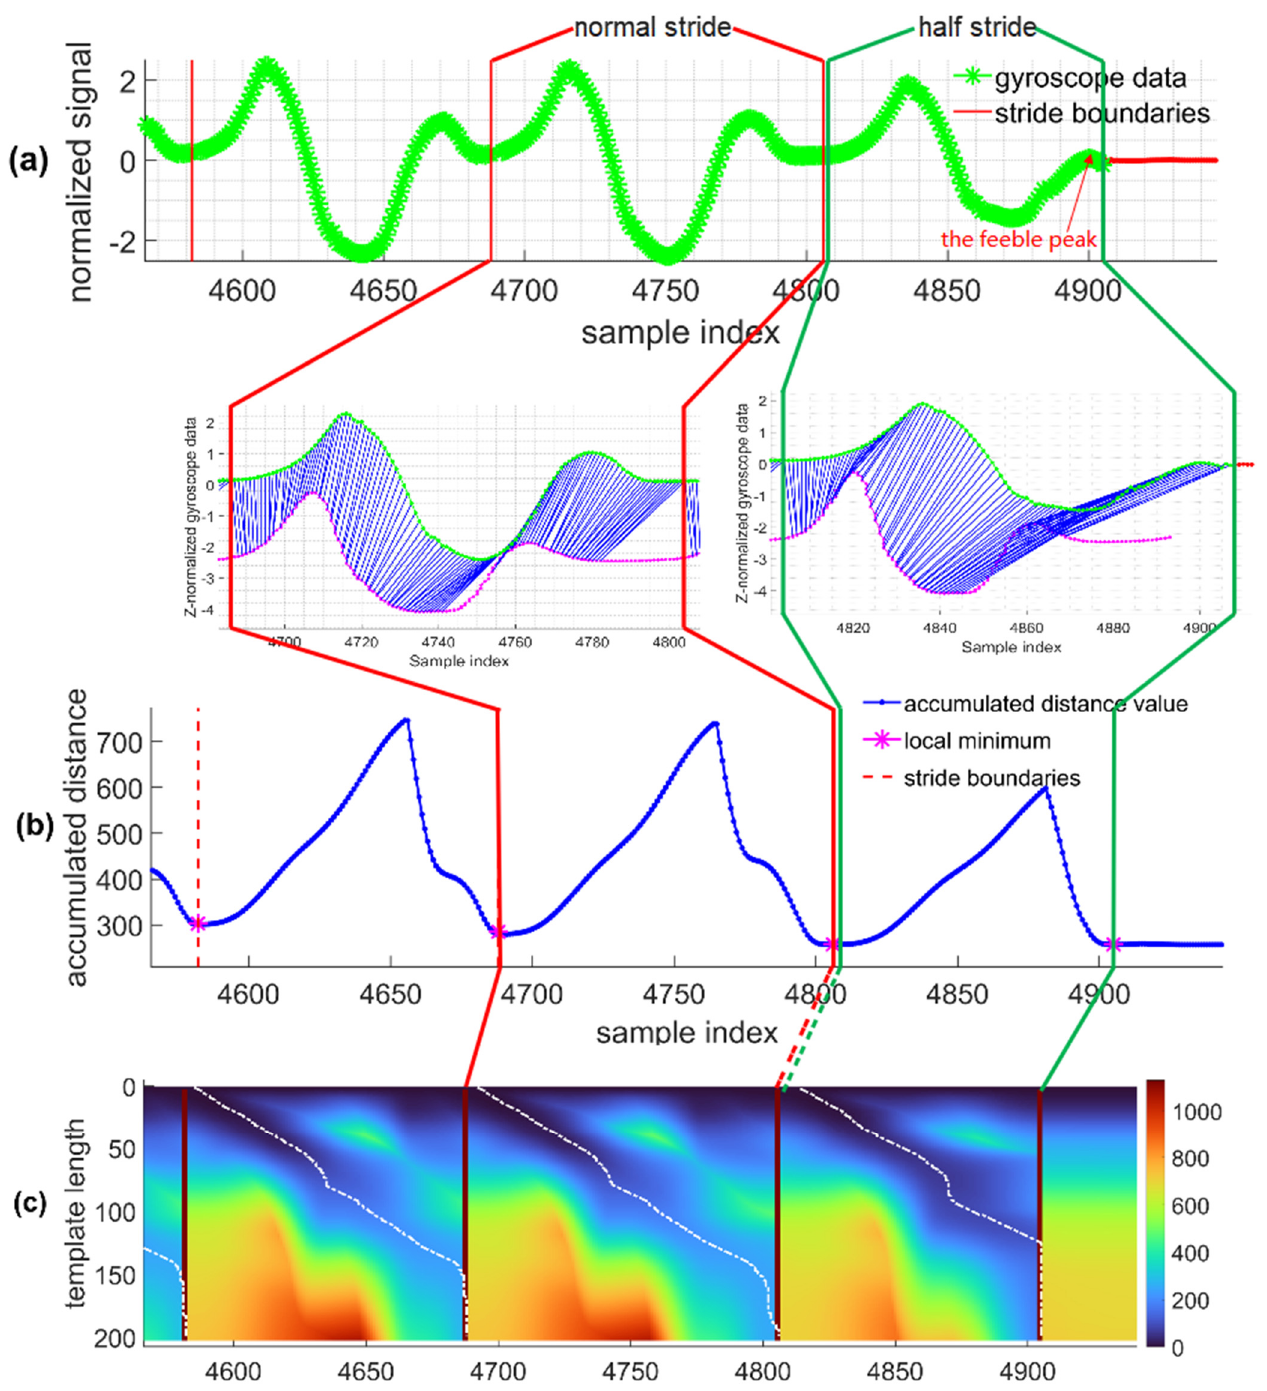
Figure 3. The effect of stride segmentation method based on SDATW algorithm. ( a ) After applying the SDATW on gyroscope coronal-axis data, the stride borders are available, which are represented as red vertical lines. And the stride segments just look like the template. Two subfigures demon- strate detailed alignment pairs of the two segments corresponding to the stride template; ( b ) The accumulated distance curve used in SDATW methods maintain the smoothness and monotonicity in normal strides and the “half-stride” situations; ( c ) Three white lines represent the warping paths which correspond to best-matched subsequences in the query sequence. Dark red ribbons between two warping paths indicate the borders of detected stride segments. The red lines and the dark green lines are used to show related information of a normal stride and a half stride, respectively.